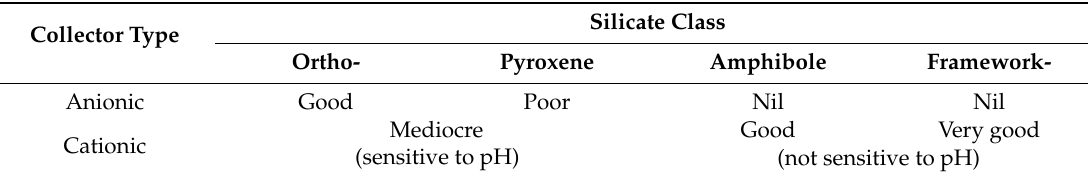
Table 4. Floatability of di ff erent silicates by structure in the presence of cationic and anionic collector (after